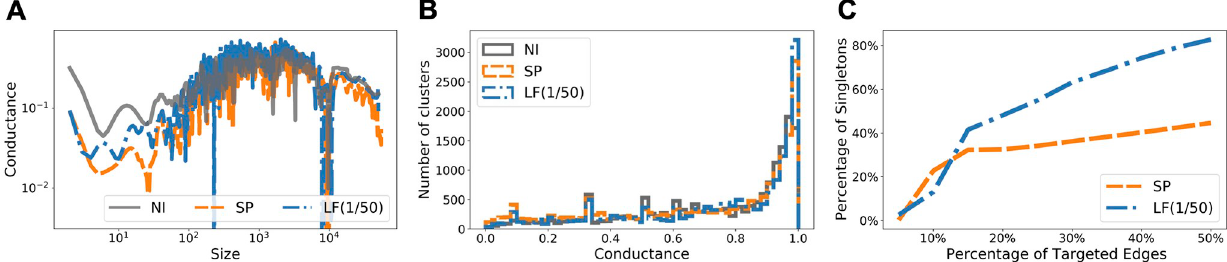
Fig 7. Characteristics of the modified Wi-Fi Montreal networks due to targeted interventions using different edge-betweenness measures. Locality bias of LF betweenness for Wi-Fi Montreal is illustrated by the dramatic difference in Fig 7C: When the network has too many singleton nodes, LF intervention isolates those nodes. (A) NCPs (see Methods for a brief introduction). (B) Distribution of clusters by conductance. (C) Isolation of singleton nodes.